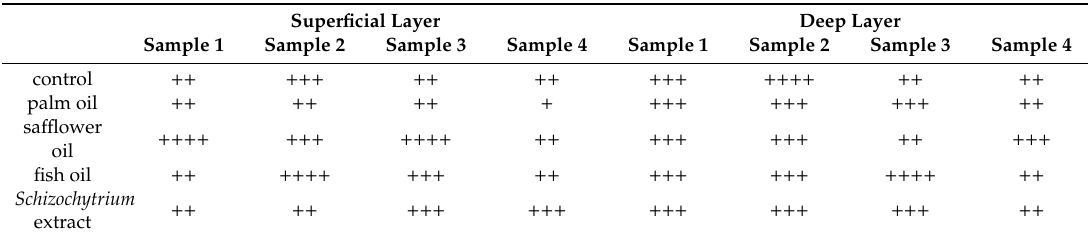
Table 1. Semi-quantitative analyses of macrophages by immunolabeling of